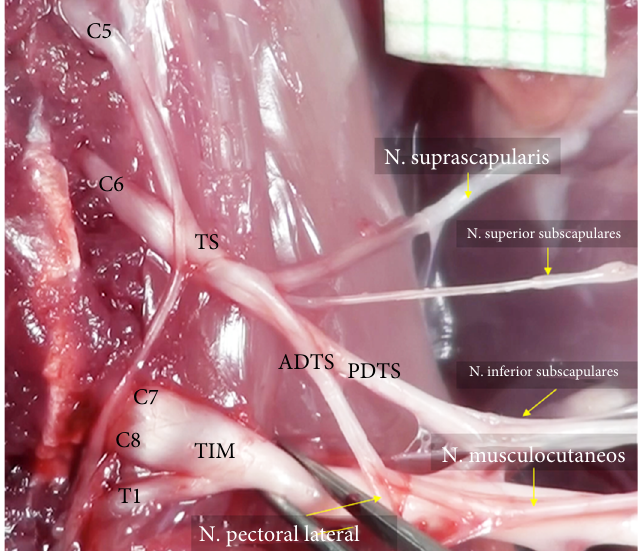
Figure 2 - A variation of the truncus inferio-medialis of right PB in the rat. C5, C6, C7, C8, and T1: ventral roots of the PB, TS: truncus superior; TIM: truncus inferio-medialis. AD: anterior division; PD: posterior